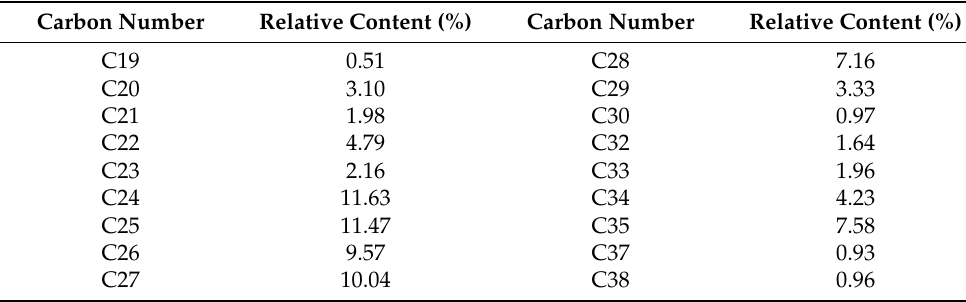
Figure 6. The GC/MS chromatogram of WEO. Table 3. The chemical composition of C19 to C38 of